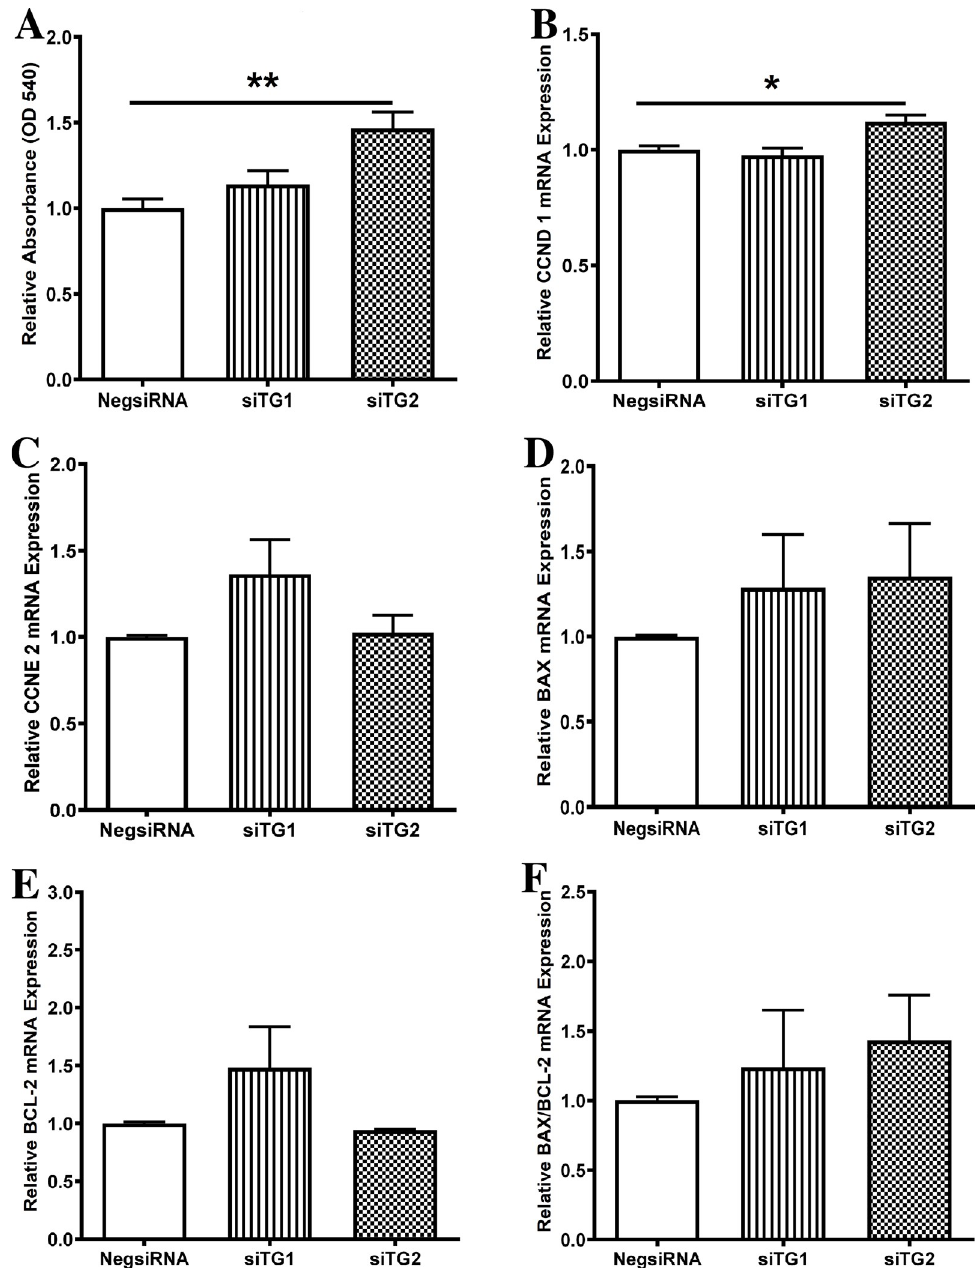
Fig 4. Knockdown of transglutaminase 2 (TG2) in neonatal rat ventricular fibroblasts increased cell proliferation and mRNA expression of the CCND 1 proliferation marker. Effect of transfection of ventricular fibroblasts with siTG1 or siTG2 (n = 4 replicates) on (A) relative cell viability (proliferation) and relative mRNA levels of (B) cyclin D1 (CCND 1), (C) cyclin E2 (CCNE 2), (D) B-cell lymphoma 2 (BCL-2)-associate X protein (BAX), and (E) BCL-2, and (F) BAX/ BCL-2 ratio. mRNA abundance of apoptotic and proliferation markers was normalized to that of β 2 microglobulin. Results are means ± SEM; one-way ANOVA followed by Dunnett’s multiple comparison test was performed. � P < 0.05 vs. Negative control (NegsiRNA); �� P < 0.01 vs. NegsiRNA.